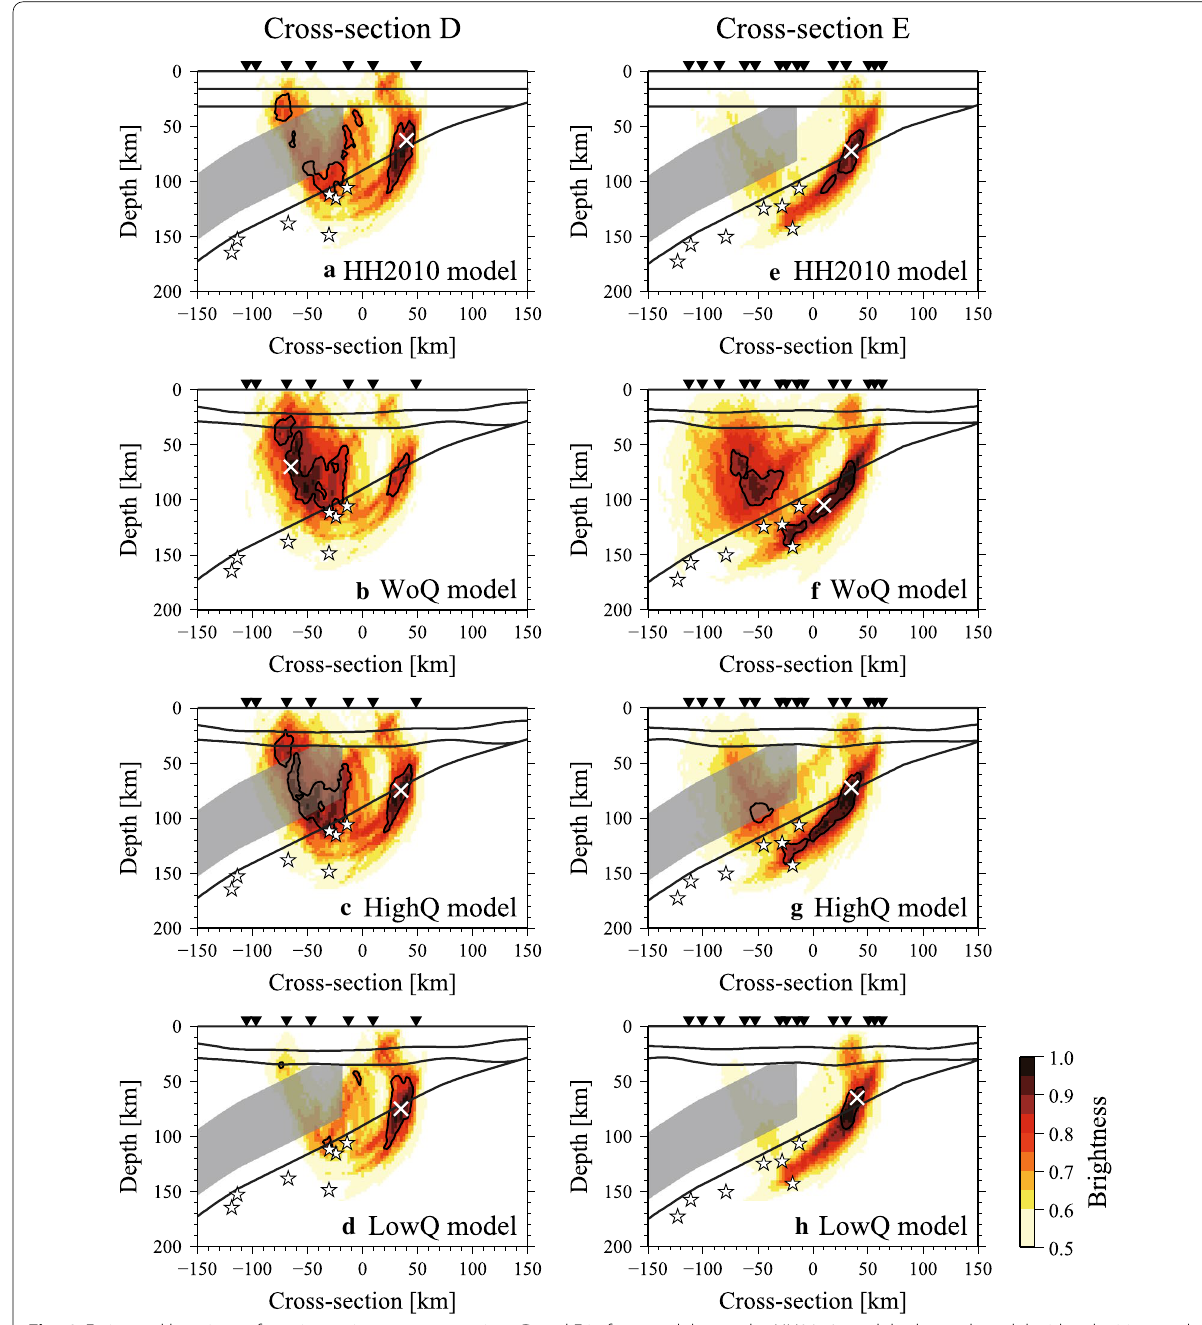
Fig. 6 Estimated locations of passing points at cross-sections D and E in four models: a , e the HH2010 model, a layered model with velocities used in Hasemi and Horiuchi (2010). b , f The WoQ model, excluding attenuation effects. c , g The HighQ model: assuming weak attenuation ( Q S = 300 ) in the backarc mantle wedge (gray-shaded area). d , h The LowQ model, assuming strong attenuation ( Q S = 100 ) in the backarc mantle wedge. The attenuation structure in the HH2010 model and the velocity structure in the WoQ, HighQ, and LowQ models are the same those shown in Fig. 4. Other symbols are explained in the caption of Fig.